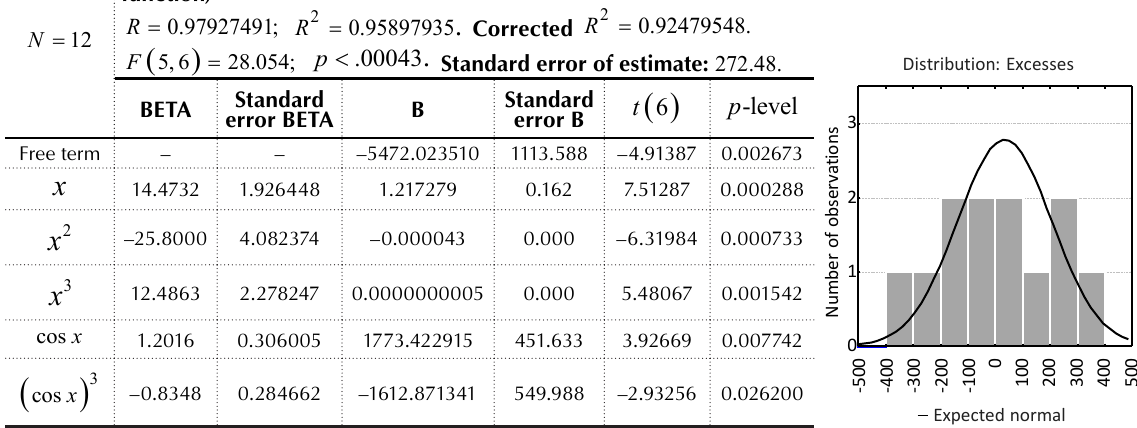
Table 6a. The results of regression for standard deviation of the size of the Investor Compensation Company Limited (Ireland) ( ) y from its volume ( ) x Regression results for dependent variable: risk (Ireland target 12 N =